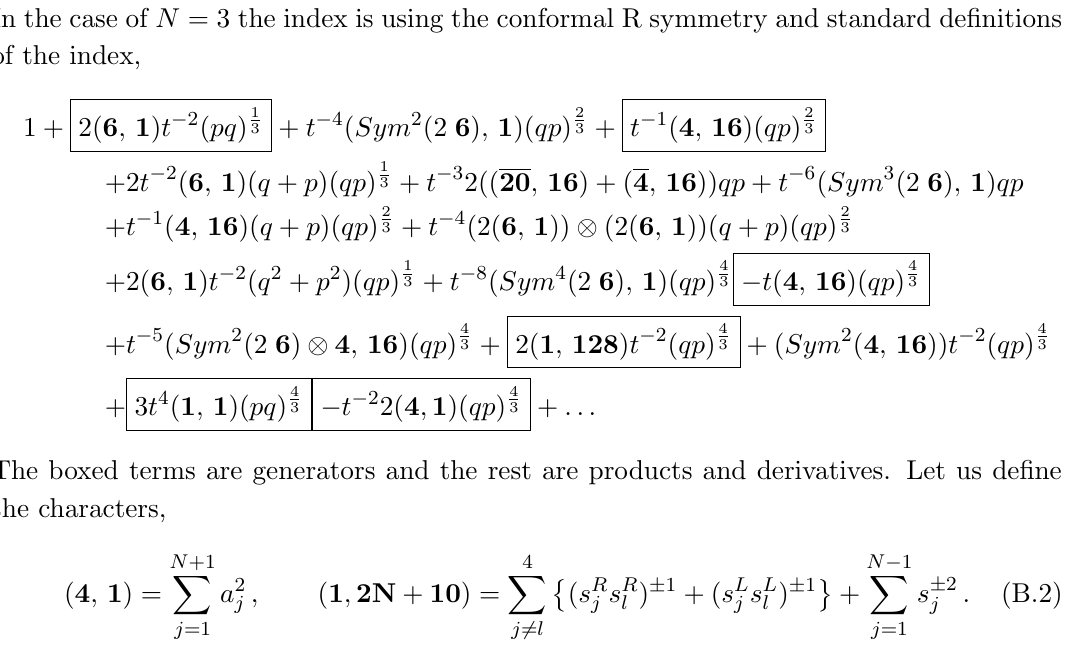
SO(6) symmetries (cid:24) a l = 1 and this gives l =1